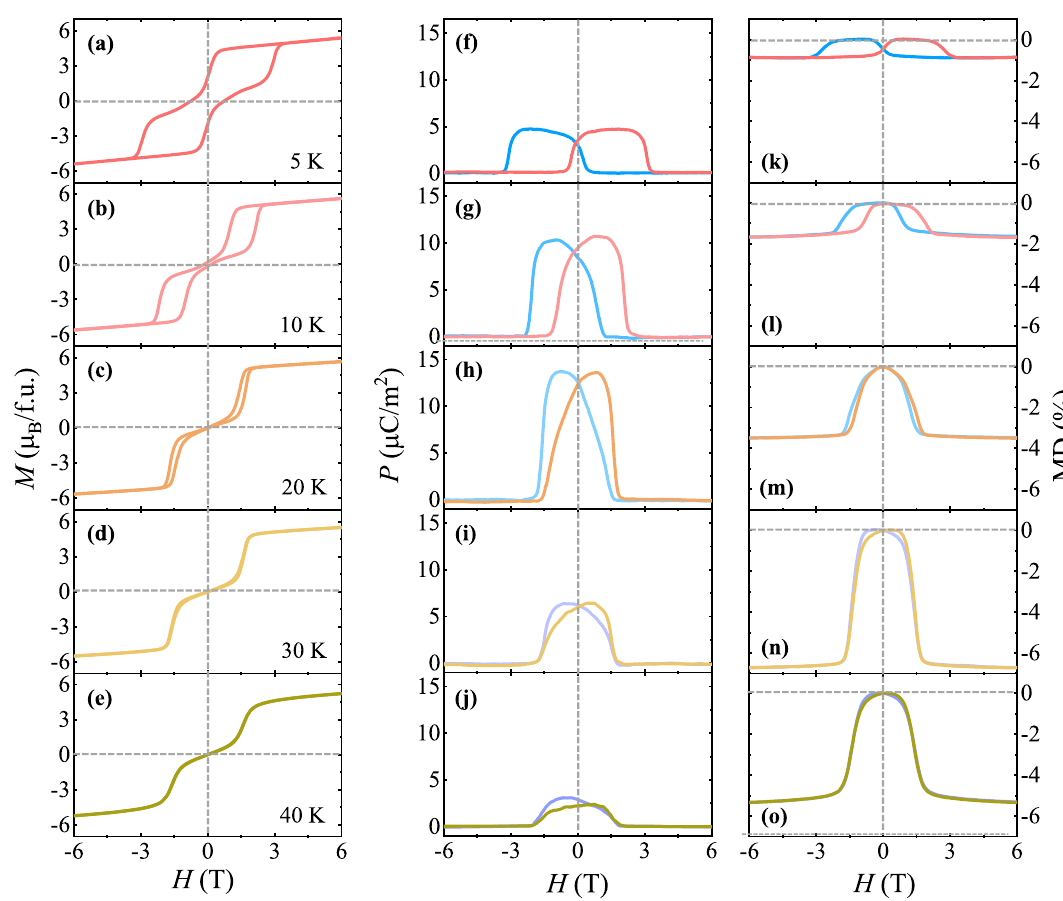
Figure 3. Temperature evolution of magnetic and ferroelectric properties. ( a )–( e ) Isothermal magnetization at H up to ± 6 T along the c axis and T = 5, 10, 20, 30, and 40 K. ( f )–( j ) Ferroelectric polarization perpendicular to the c axis at H up to ± 6 T along the c axis and T = 5, 10, 20, 30, and 40 K, obtained by integrating the magnetoelectric current measured and changing H at the rate of 0.01 T/s up to ± 6 T after poling at E = 2.3 kV/ cm. ( k )–( o ) Magnetodielectric (MD) effect defined as MD (%) = ε for H up to ± 6 T along the c axis at T = 5, 10, 20, 30, and 40 K.